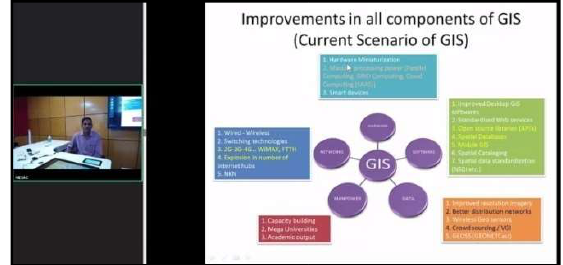
Figure 6. Mr. P. L. N. Raju delivering a lecture during the